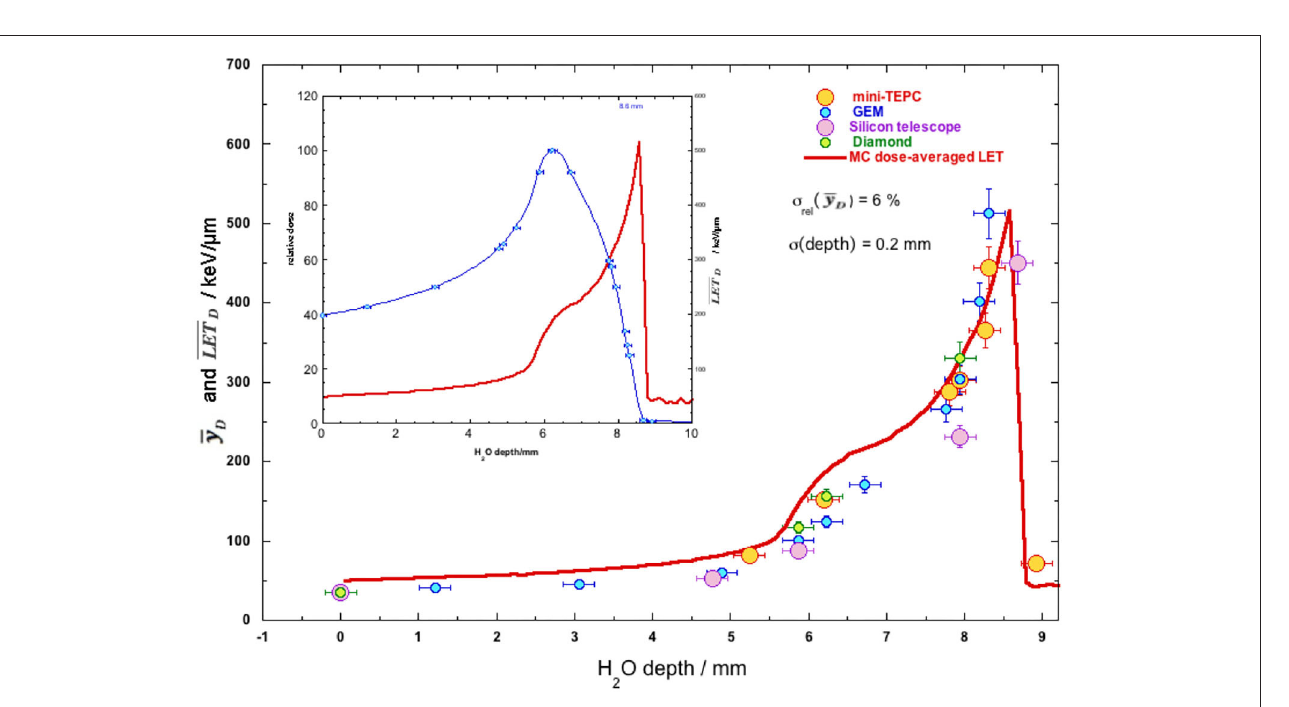
FIGURE 11 | Measured y D and calculated dose-averaged linear energy transfer ( LET D ) values in water of 12 C ion beam of 62 MeV/u at different water depths. The y D values of the four different detectors have been plotted with different colors. In the insert, the relative dose (blue thin line) and the LET D depth profile (red thick line) with the detector positions are presented. Data from Colautti et al.